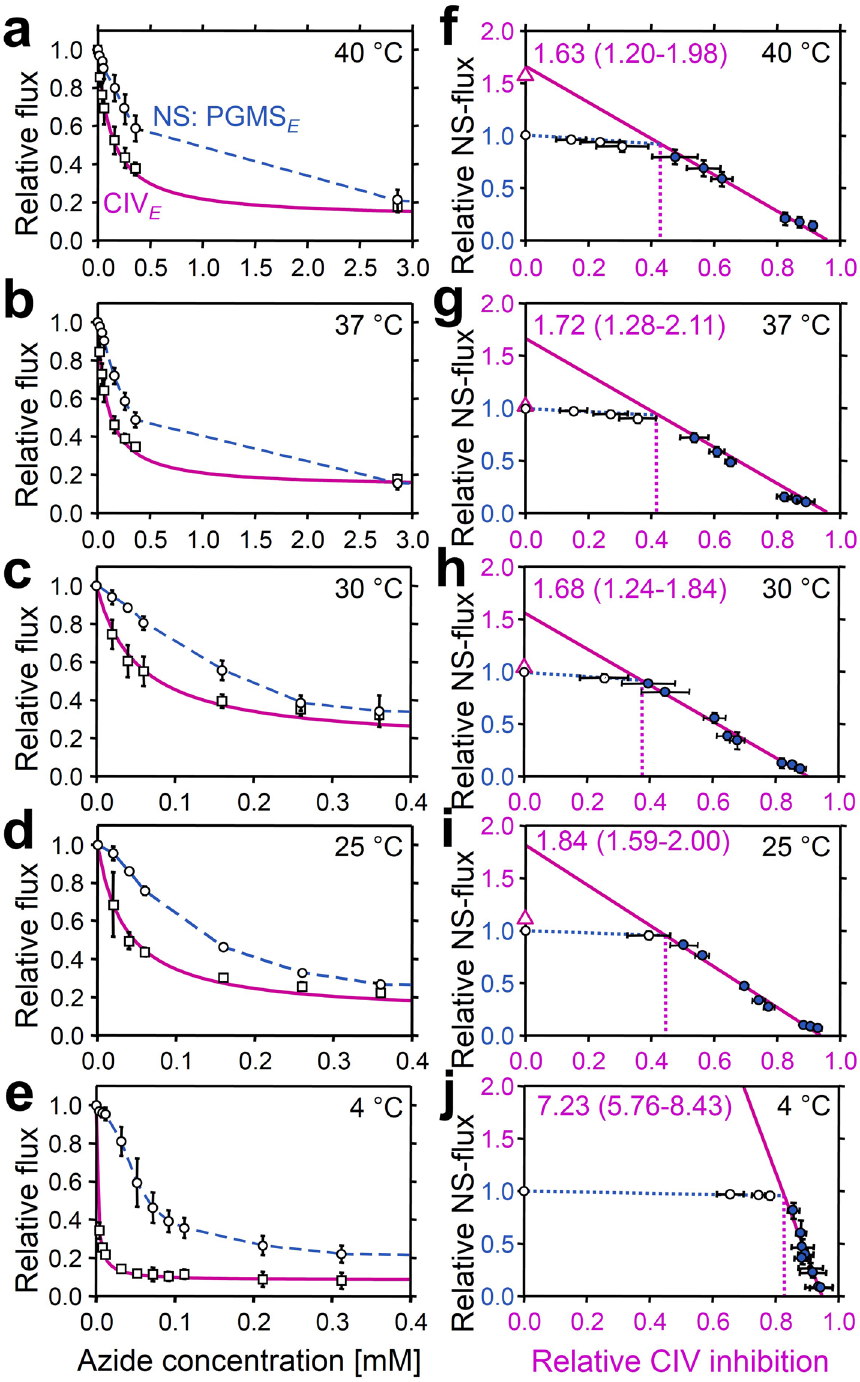
Figure 5. Azide titration and Complex IV threshold in permeabilized cardiac fibers at 40 to 4 °C. ( a to e ) Effect of azide titration on relative NS-pathway ETS capacity (PGMS E ; circles, dashed line: linear interpolations) and velocity of the single enzyme cytochrome c oxidase (CIV E ; squares, solid line: hyperbolic fit). ( f to j ) Threshold plots of relative NS-pathway flux as a function of relative inhibition of CIV at identical azide concentrations. Data up to the threshold of inhibition are shown by open symbols. The CIV E 0 /NS E flux ratio is calculated as the intercept at zero CIV inhibition of a linear regression through the data above the inflection point (closed symbols; r 2 ≥ 0.99). CIV E 0 /NS E values are listed in the graphs as medians (min to max). The apparent excess capacity of CIV is j intercept between the linear regression and the extrapolated line drawn from the control to the first inhibited flux (dotted vertical lines). Circles are means ± SD ( n =